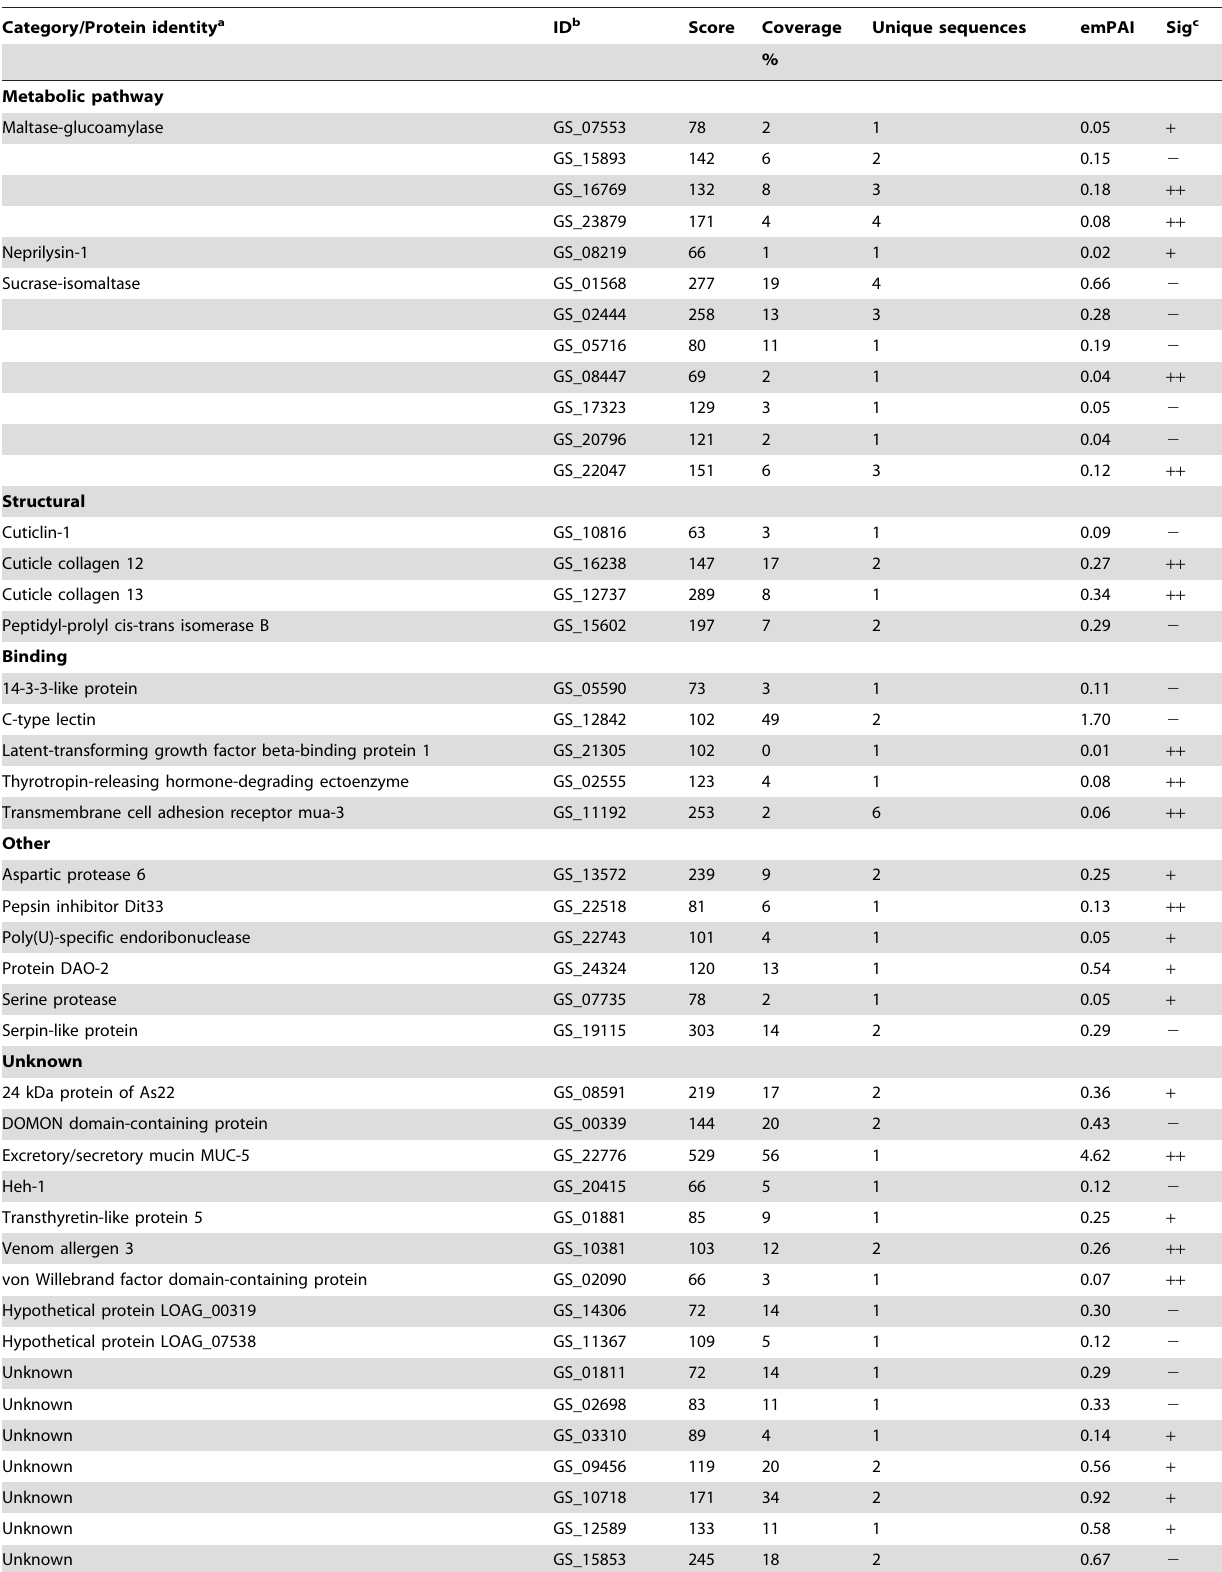
Category/Protein identity